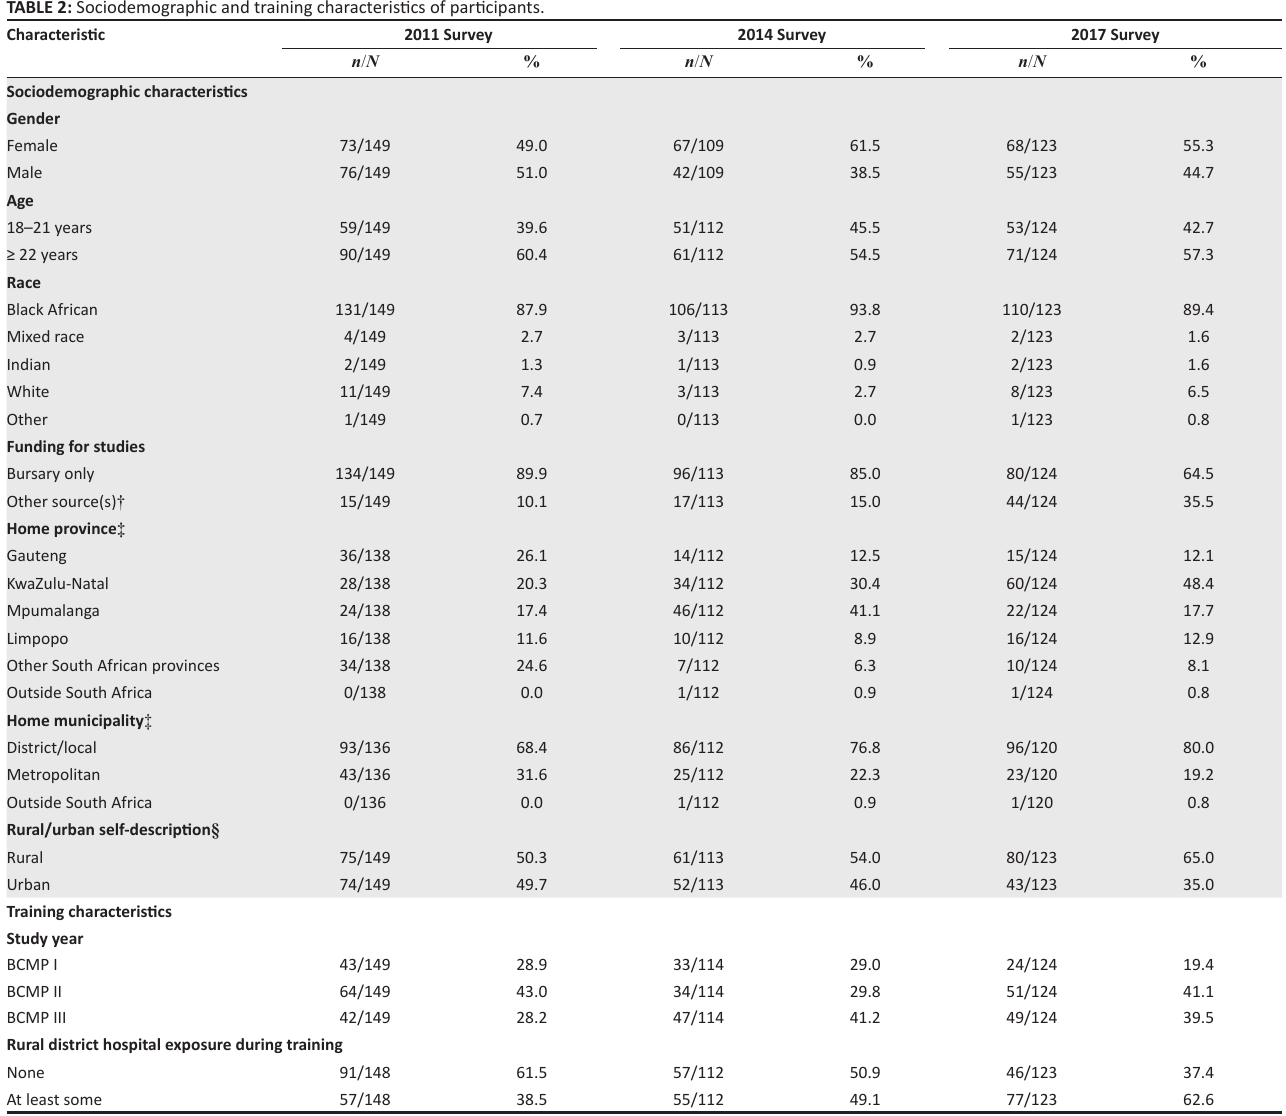
TABLE 2: Sociodemographic and training characteristics of participants. Characteristic